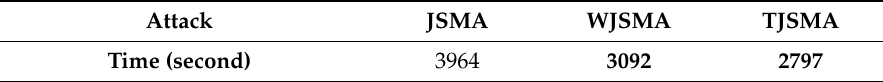
Table 3. Time comparison between JSMA, WJSMA and